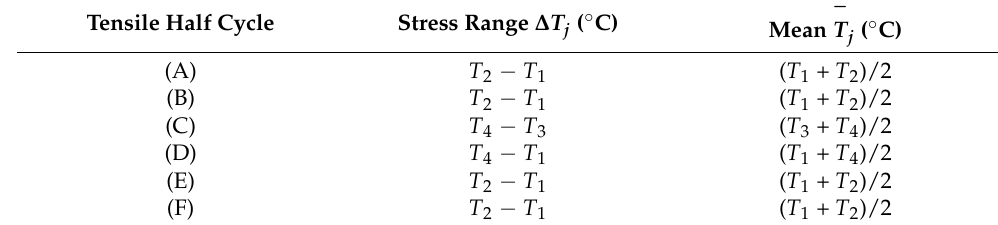
Figure 7. Example of rainflow counting for the semiconductor thermal profile. ( a ) Thermal stress history of a semiconductor. ( b ) Peak–valley history of a semiconductor. ( c ) Half cycles that start from tensile peaks. ( d ) Half cycles that start from compressive valleys. Table 6. Half-cycle counting for tensile peaks.